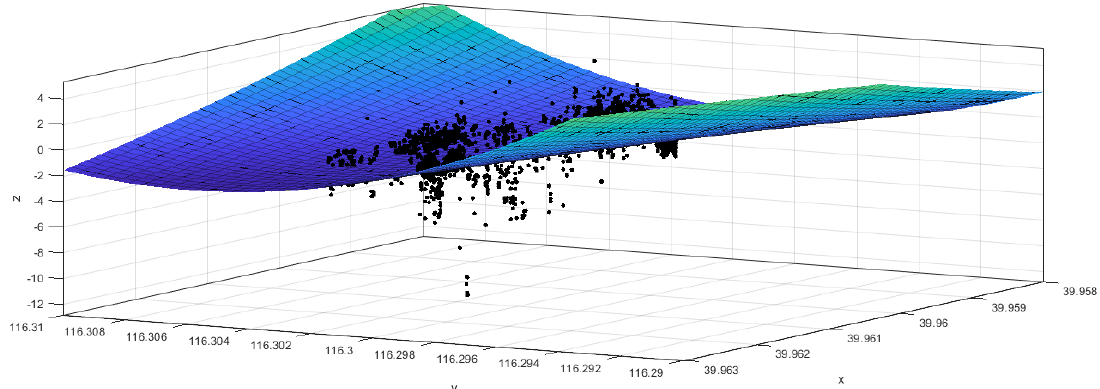
Figure 6. Fitting result using quadratic polynomial surface interpolation method.